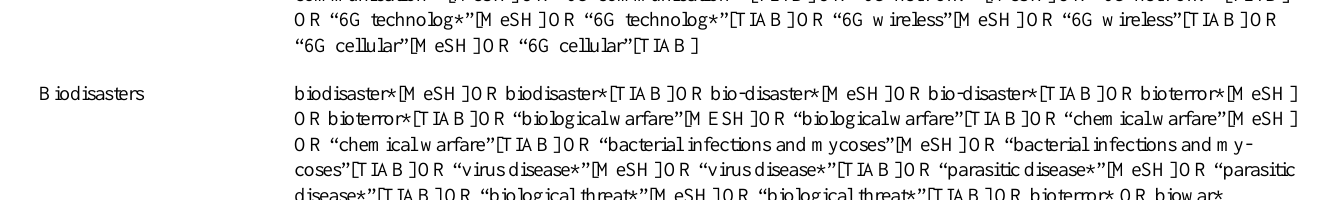
Inclusion criteriaData type Centered on discussions about biodisasters (disasters that occur as a result of infectious pathogens with bioweapon potentials unleashed by state or nonstate Artificial intelligence and 6GTechnology